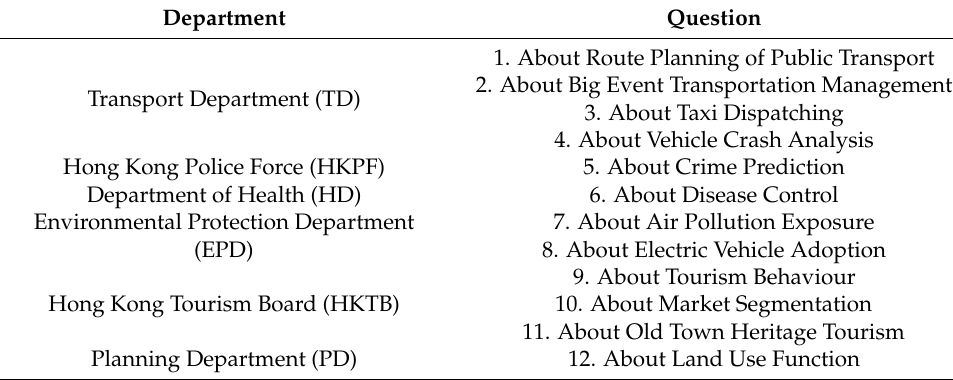
Table 2. Enquiries sent to departments of Hong Kong